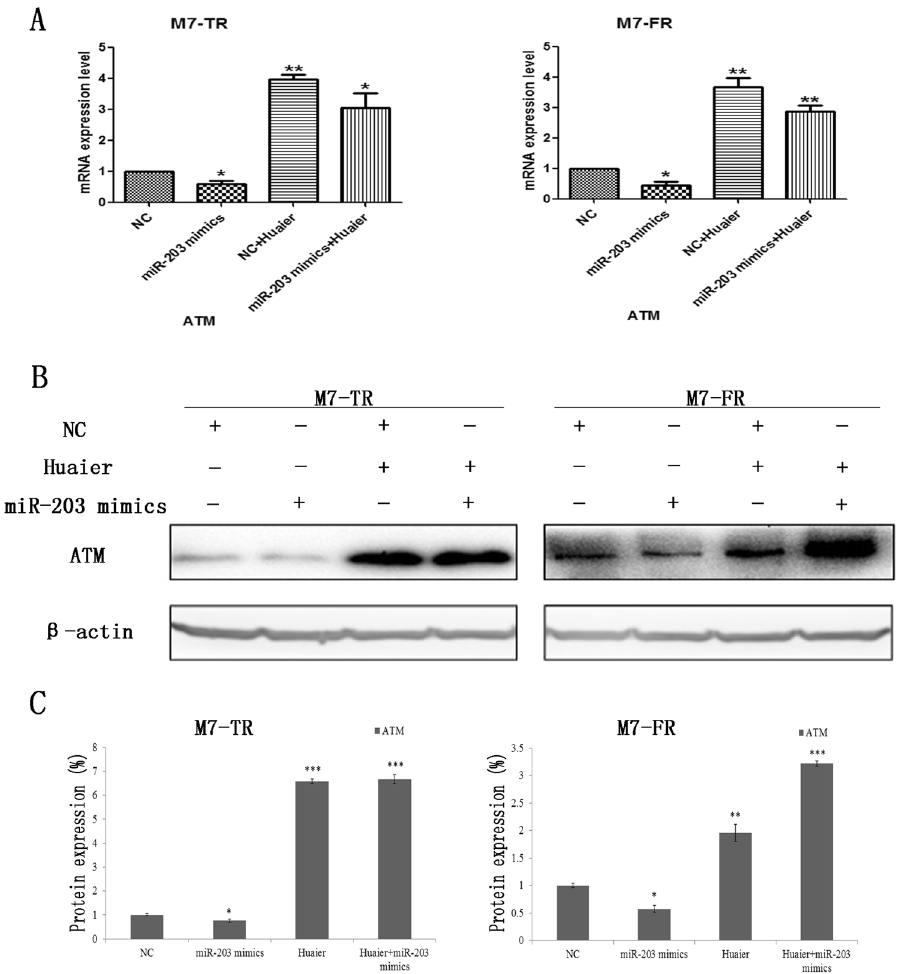
Figure 5. Huaier extract up-regulated ATM by suppressing miR-203 in M7-TR and M7-FR cells. ( A ) qRT-PCR analysis demonstrated that the transfection of miR-203 mimics reversed the mRNA changes of ATM induced by combined treatment with Huaier extract. ( B and C ) The protein expression levels of ATM after transfection of miR-203 mimics alone or combined with Huaier extract in M7-TR and M7-FR cells. * P < 0.05 or ** P < 0.01, compared with the controls. The data are presented as the mean ± SD of three separate